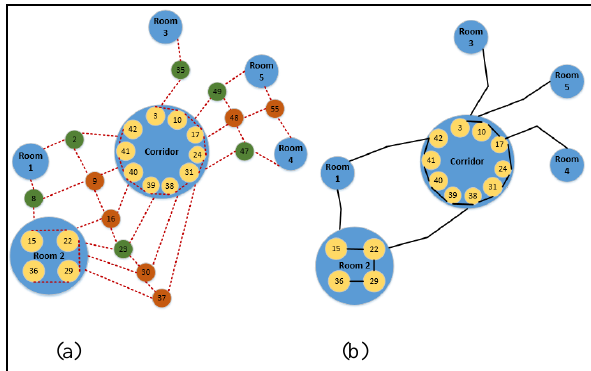
Figure 9. Topology graphs reconstructed for the real point cloud of the office building containing adjacency and containment relations (a), and connectivity and containment relations (b).